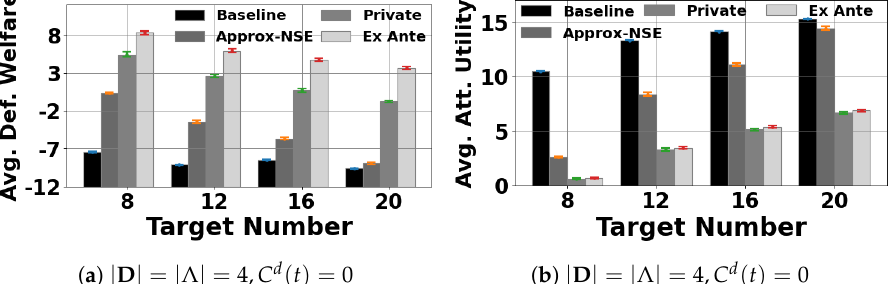
Figure 3. All evaluated algorithms, no patrolling costs.